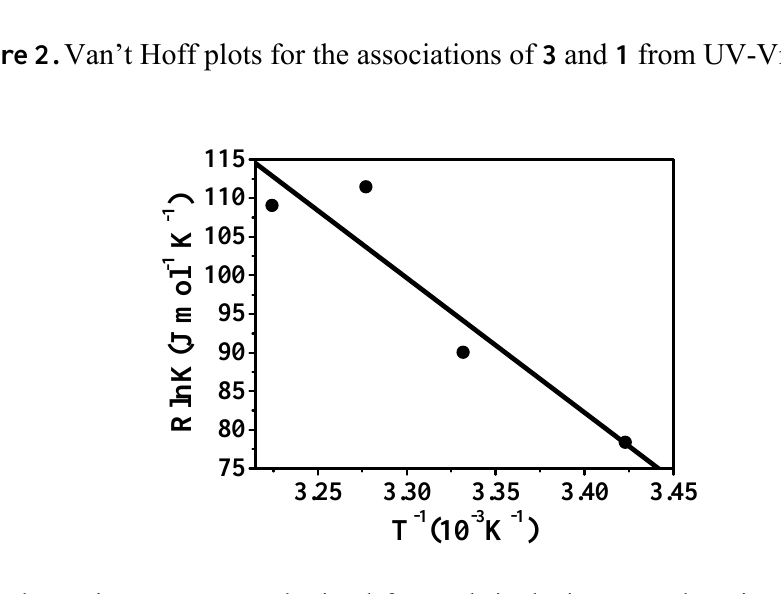
Table 1. Complex stability constant ( K and 2 in the aqueous buffer solution (pH 7.4) at 32 ° C.